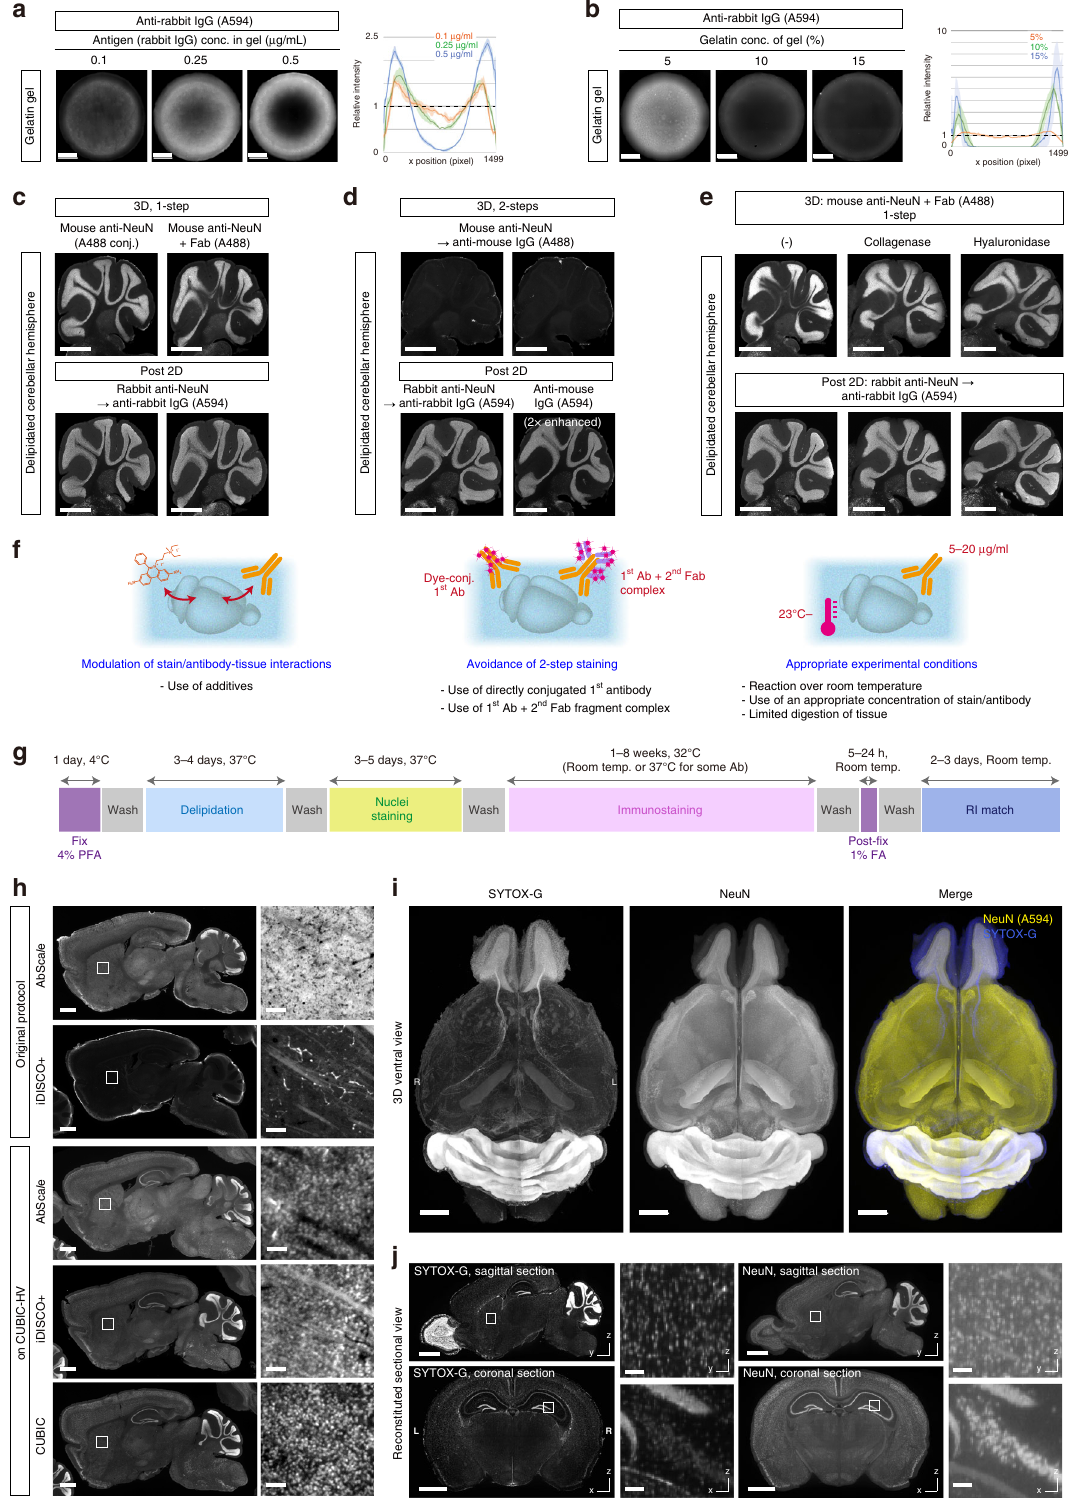
(ECM). We treated the tissue with collagenase or hyaluronidase under highly stringent conditions to achieve limited digestion. The treatment indeed ameliorated the edge binding of the antibody (Fig. 3e). Taken together, we postulated the essential conditions for an ef fi cient 3D staining protocol as follows: (1) modulation of the interactions between dye/antibody and tissue by chemical